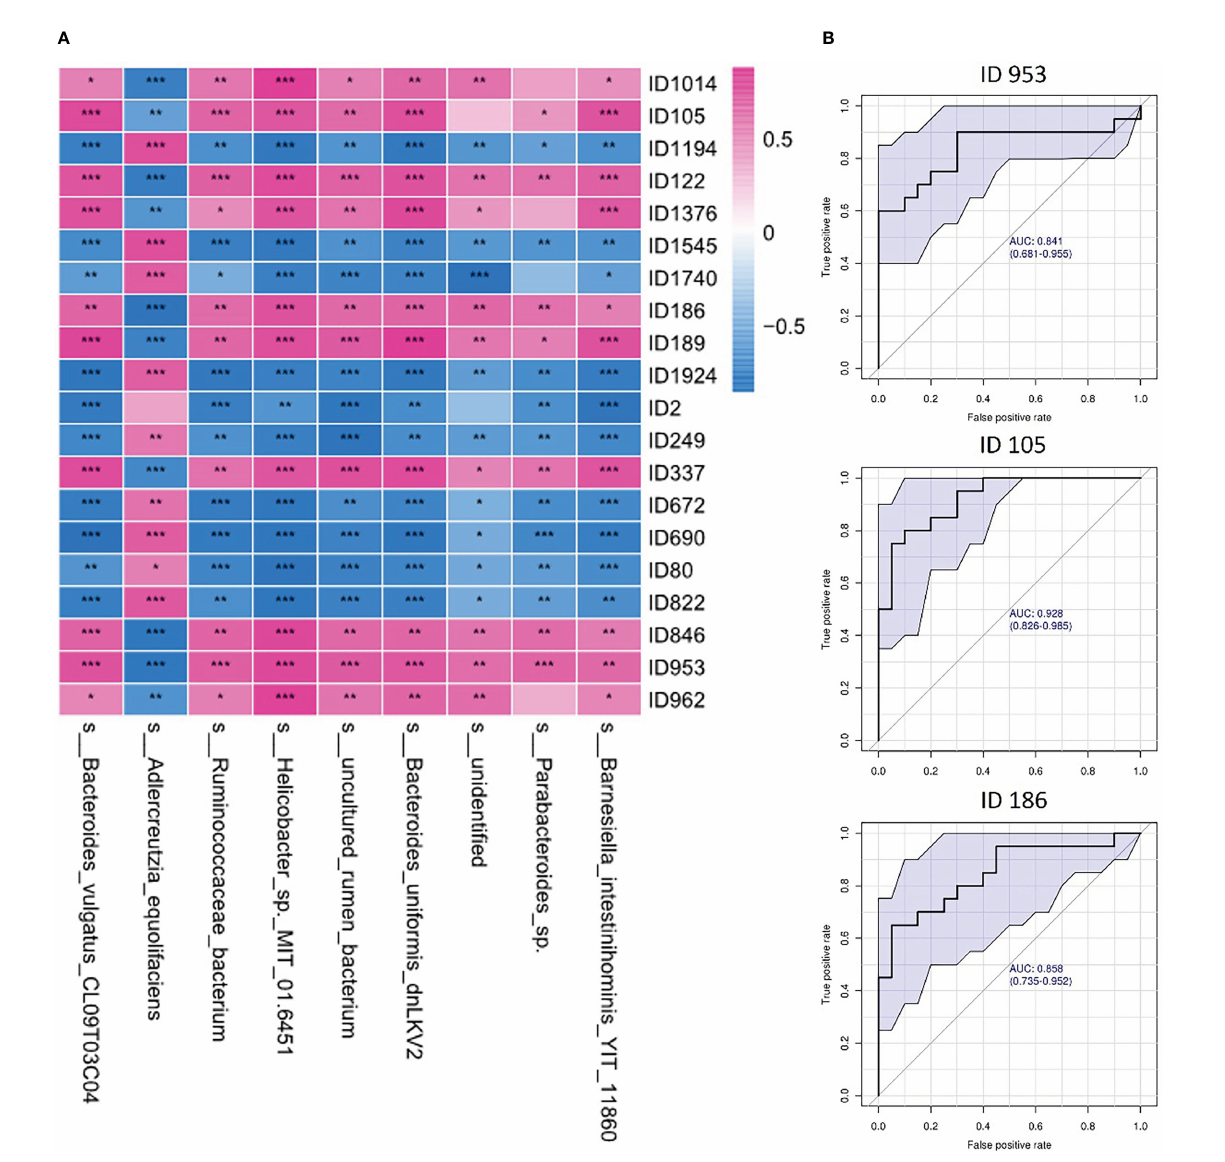
FIGURE 6 Correlations between gut microbes and fecal metabolites. (A) Heatmap of correlations between gut microbes and fecal metabolites in depression rats; (B) ROC curve of the top 3 representative metabolites related to gut microbes (ID953: N-acetyl-d-glucosamine; ID105: 3-(3-Hydroxyphenyl) propanoic acid; ID186: N-acetyl-d-mannosamine). One asterisk (*) represents a p-value less than 0.05, two asterisks (**) represent a p-value less than 0.01, and three asterisks (***) represent a p-value less than